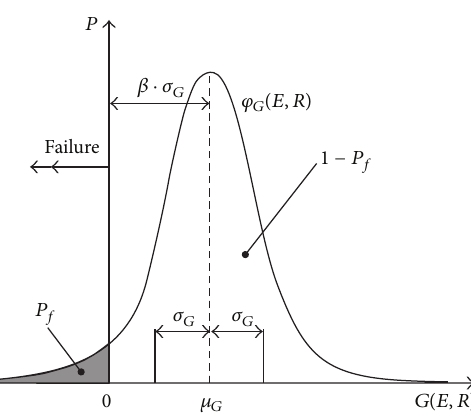
Figure 3: Determining the failure probability, 𝑃 𝑓 , and reliability index, 𝛽 , by means of the failure reliability, RF (the failure function, 𝐺